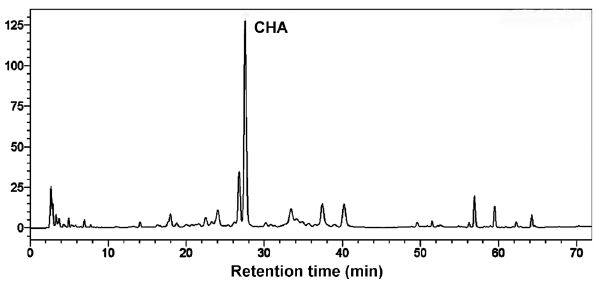
Fig 1. HPLC-chromatographic profile of phenolic compounds in apple pulp at 280 nm wavelengths. The major peak was identified by both of internal standard method and external reference method with chlorogenic acid (3-O-caffeoylquinic acid, CHA) as a standard substance.